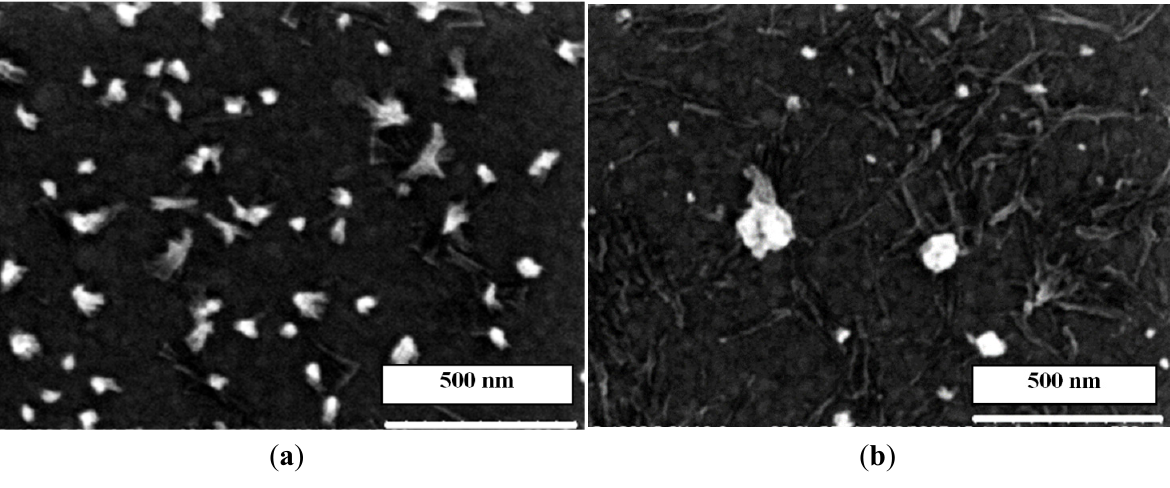
Figure 7. SEM images of TMA/M complexes fabricated on gold substrates from 0.001 M melamine and 0.001 M CA at different pH: ( a ) pH = 5; ( b ) pH = 9.